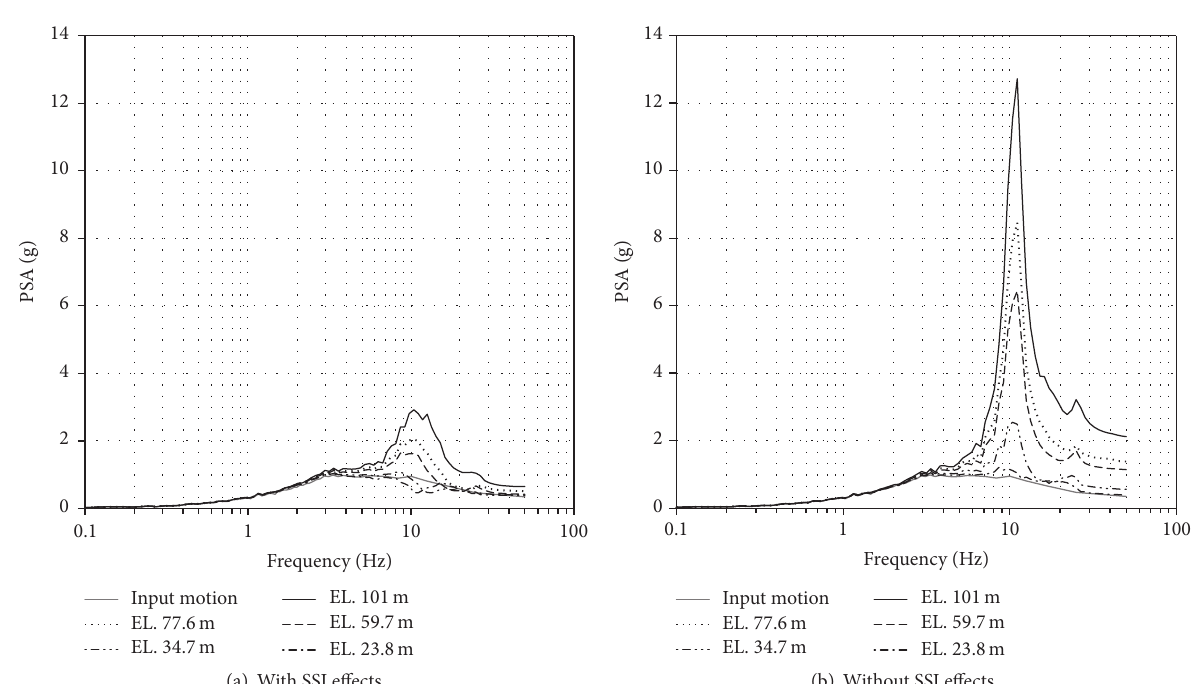
Figure 17: The response spectral acceleration for different elevations of the Reactor Containment Building and vertical motion input.